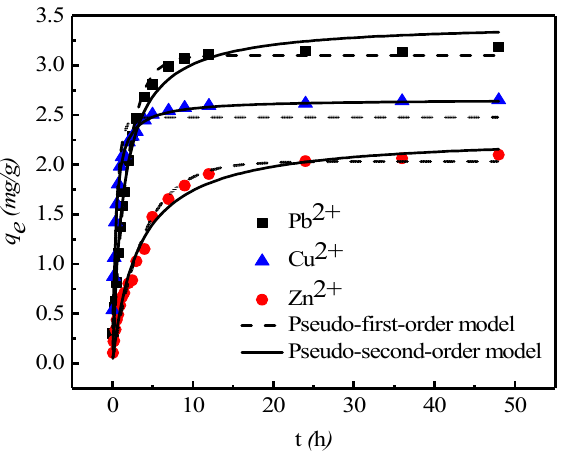
Figure 2. Adsorption kinetics of Pb 2+ , Cu 2+ , or Zn 2+ removal by PPG-nZVI beads. Initial Pb 2+ , Cu 2+ , or Zn 2+ concentrations, 20 mg·L − 1 ; adsorbent dose, 4.0 g·L − 1 ; total solution volumes, 400 mL; pH, 5.0; temperature, 25 °C, and shaking time, 48 h. Table 1. Adsorption kinetic constants obtained by different models. Pseudo-First-Order